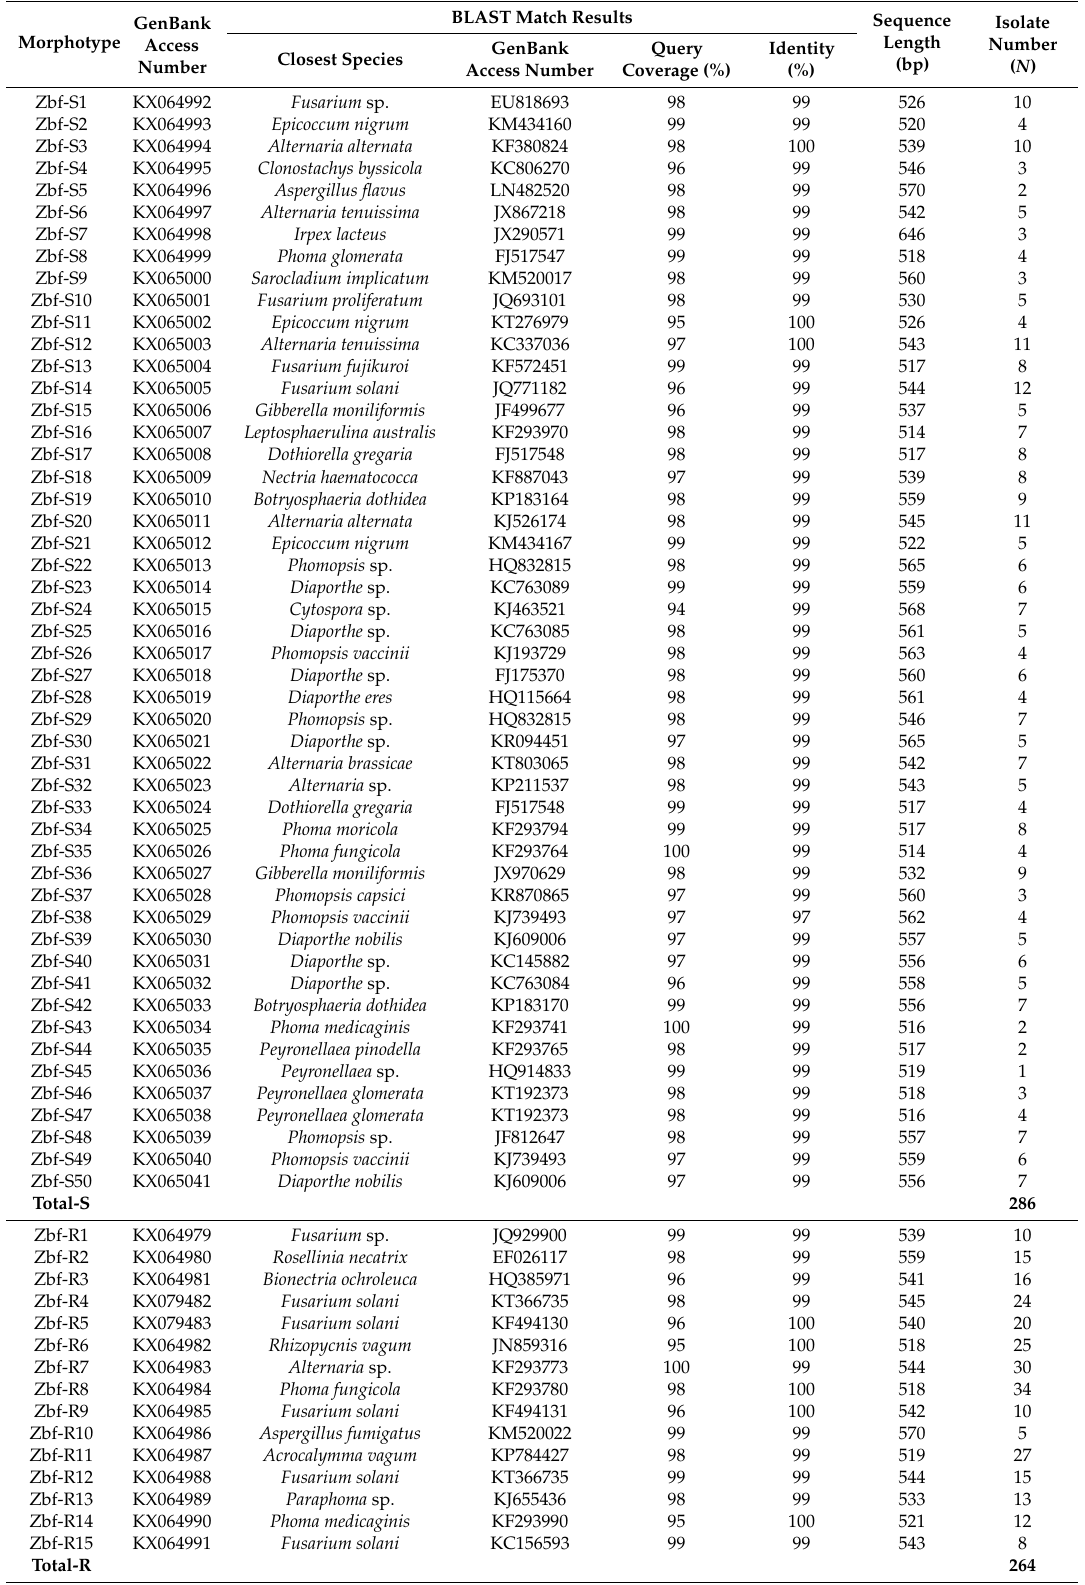
Table 1. Identification of endophytic fungi from Zanthoxylum bungeanum by basic local alignment search tool (BLAST) in